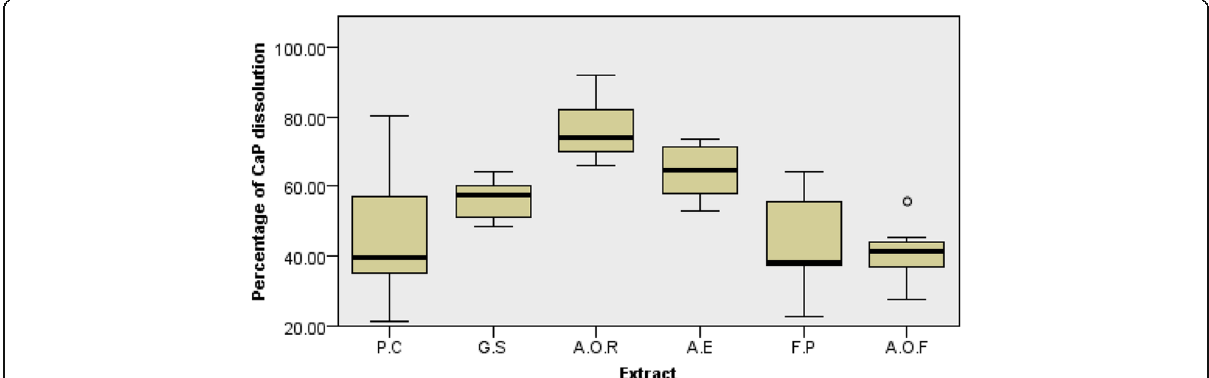
Fig. 2 Percent dissolution of phosphat calcium (CaP) by different extracts. Petroselinum crispum (P.C), Gypsophila struthium (G.S), Alcea officinalis (Root) (A.O.R), Arnebia euchroma (A.E), Ferula persica (F.P) and Alcea officinalis (Flower) (A.O.F).